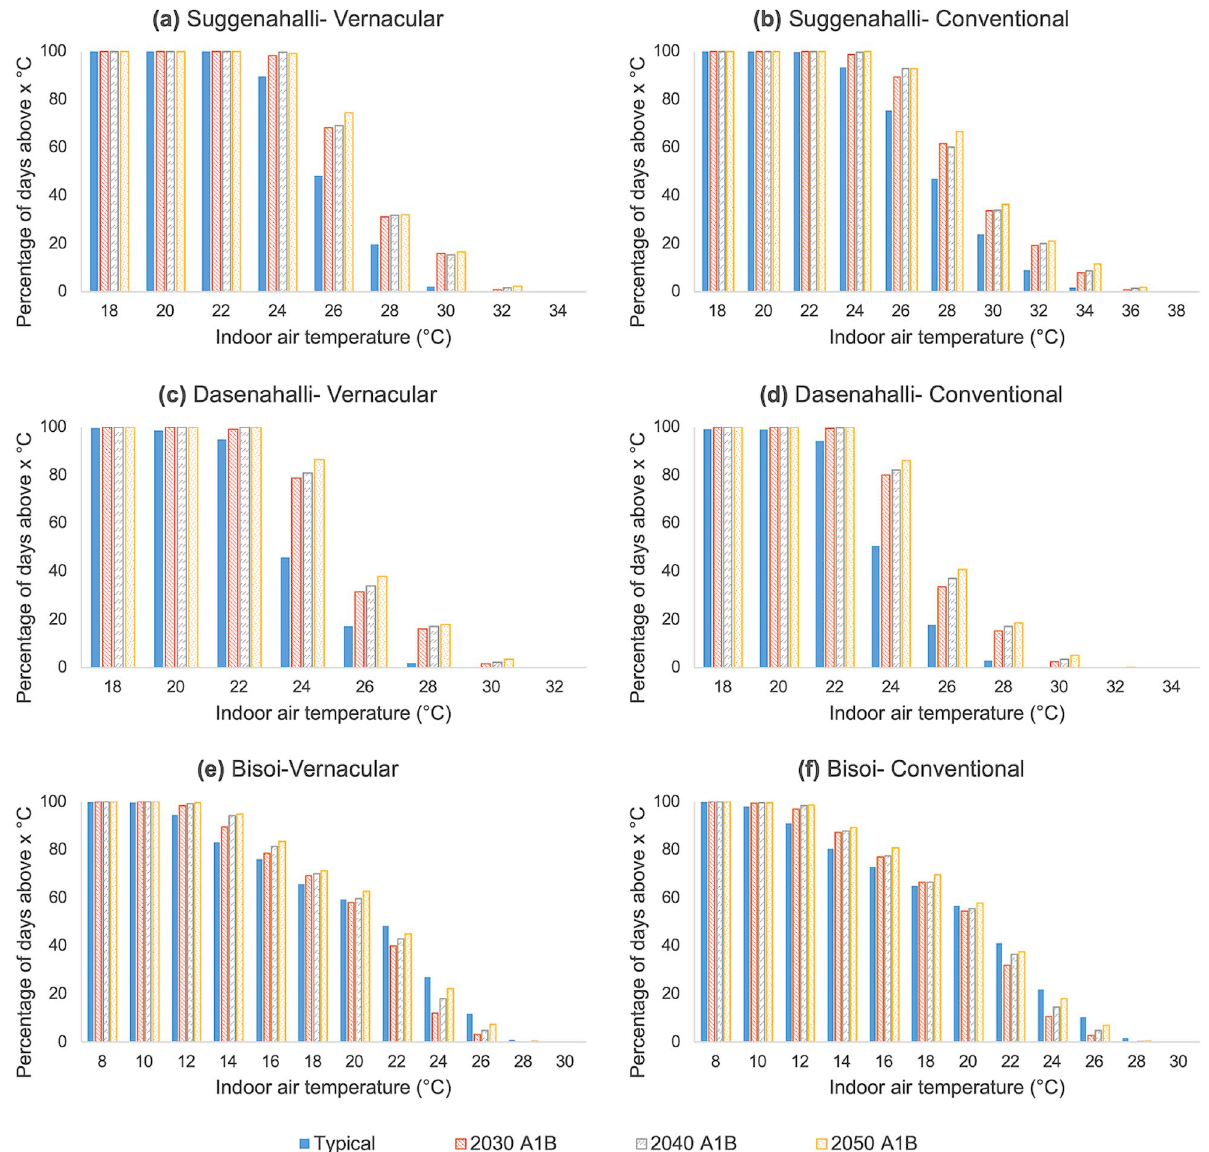
Figure 7. Percentage of days above a daily temperature given on abscissa for vernacular and conventional dwelling in the three settlements for typical scenario and future years under A1B scenario: Each bar in the plot shows the percentage of days in a year for which the mean daily indoor air temperature (in °C) is greater than the corresponding temperature (in °C) given on the abscissa. The plot helps to understand the range of temperatures and extent to which those temperatures prevail inside a dwelling throughout the year. This is shown for typical scenario and future years for A1B scenario. ( a ) and ( b ) shows the same for vernacular and conventional dwelling in Suggenahalli, ( c ) and ( d ) for dwellings in Dasenahalli and ( e ) and ( f ) for dwellings in Bisoi. Higher temperatures tend to persist in the dwellings in future years compared to typical conditions especially for conventional dwelling in case of both Suggenahalli and Dasenahalli. This is more evident in Suggenahalli than Dasenahalli. In the case of Bisoi, the frequency of lower temperatures in higher in the future compared to typical conditions, while frequency of higher temperature is higher in typical conditions than future Fig. 8a and b shows that a large number of data points lie above the acceptability limit in conventional dwell- ing compared to vernacular dwelling. Climate change further increased ACDD in the future years with highest increase in A1B scenario and lowest in A2 scenario. Cooling requirement increases considerably due to climate change and transitions especially in summer. In the case of Dasenahalli (Fig. 9d–f), both AHDD and ACDD are very low in both vernacular and conventional dwelling in typical climate. ACDD is zero in all future years while AHDD, though small, steadily increases in future years, especially for A1B scenario. Transition also affects the thermal comfort in the dwellings where transitions increased both ACDD and AHDD in typical climate,